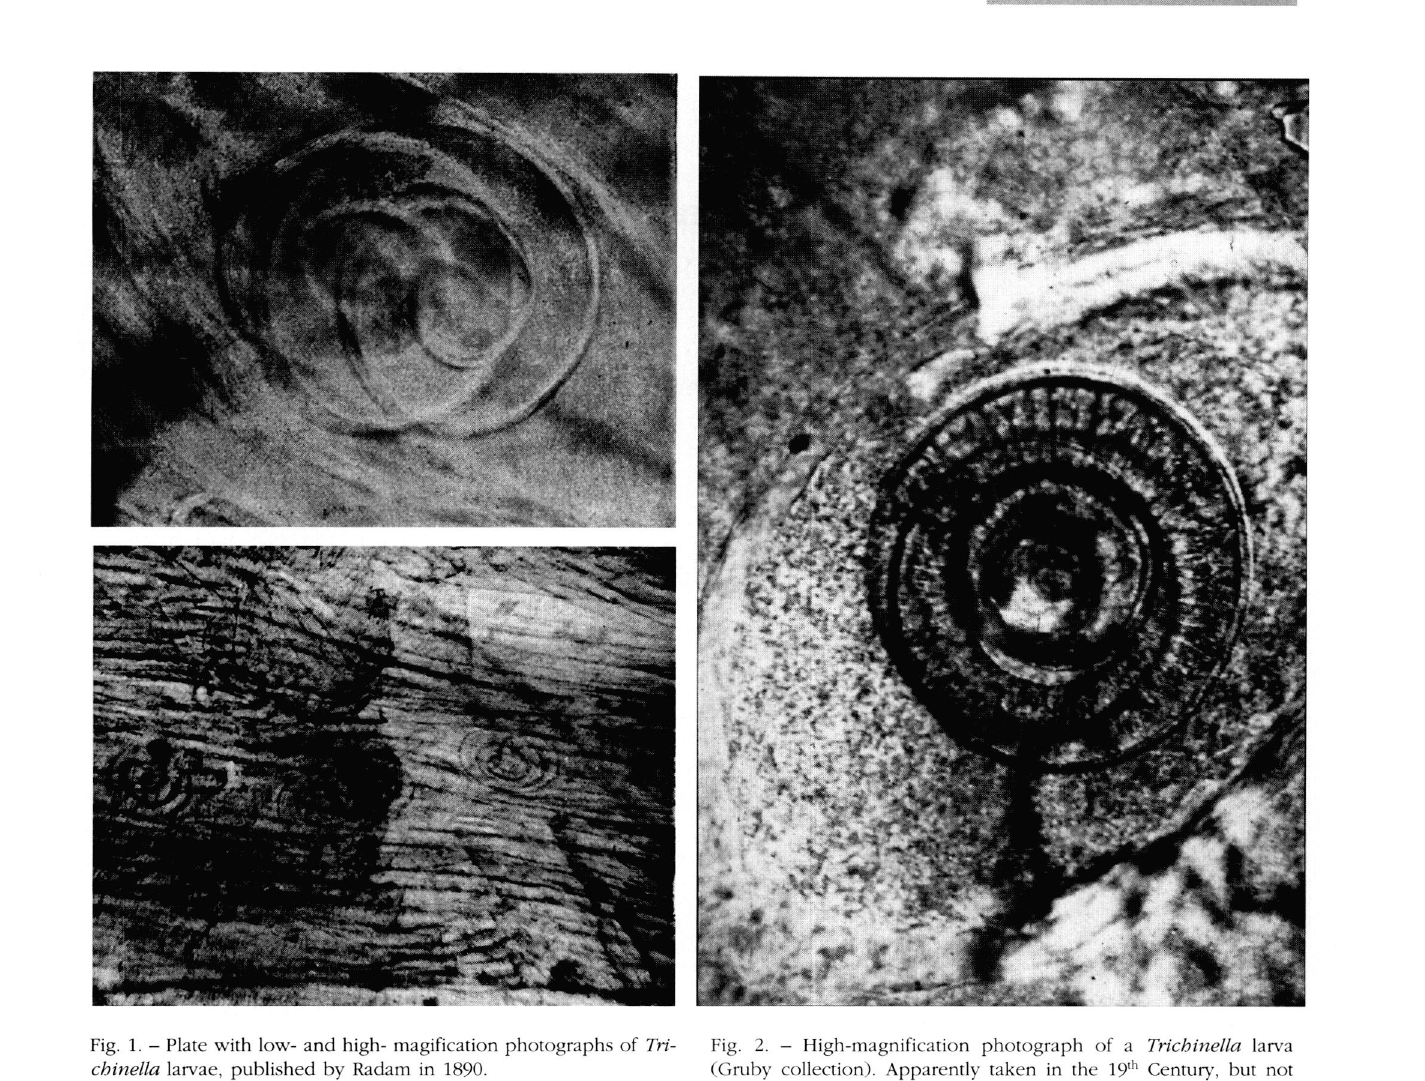
Fig. 2. - High-magnification photograph of a Trichinella larva (Gruby collection). Apparently taken in the 19 th Century, but not known to have been